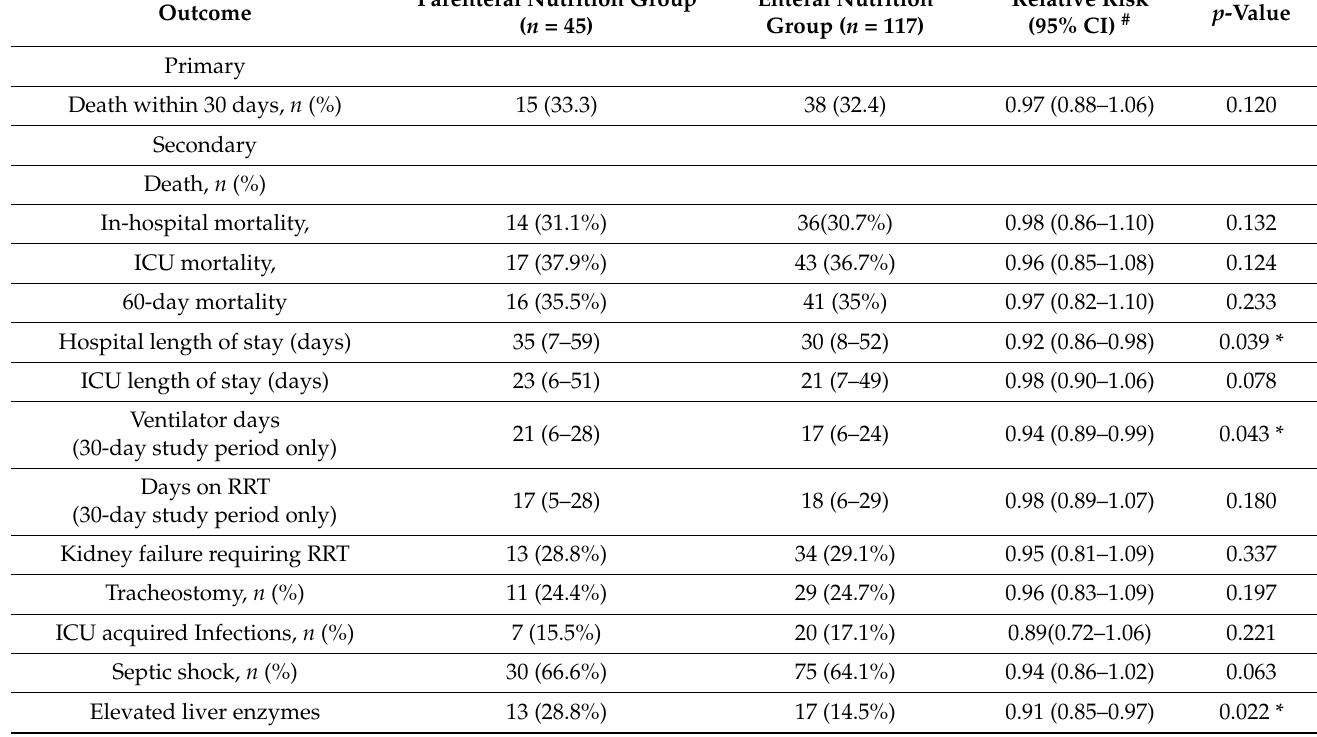
Table 2. Patients primary and secondary outcomes ( n =